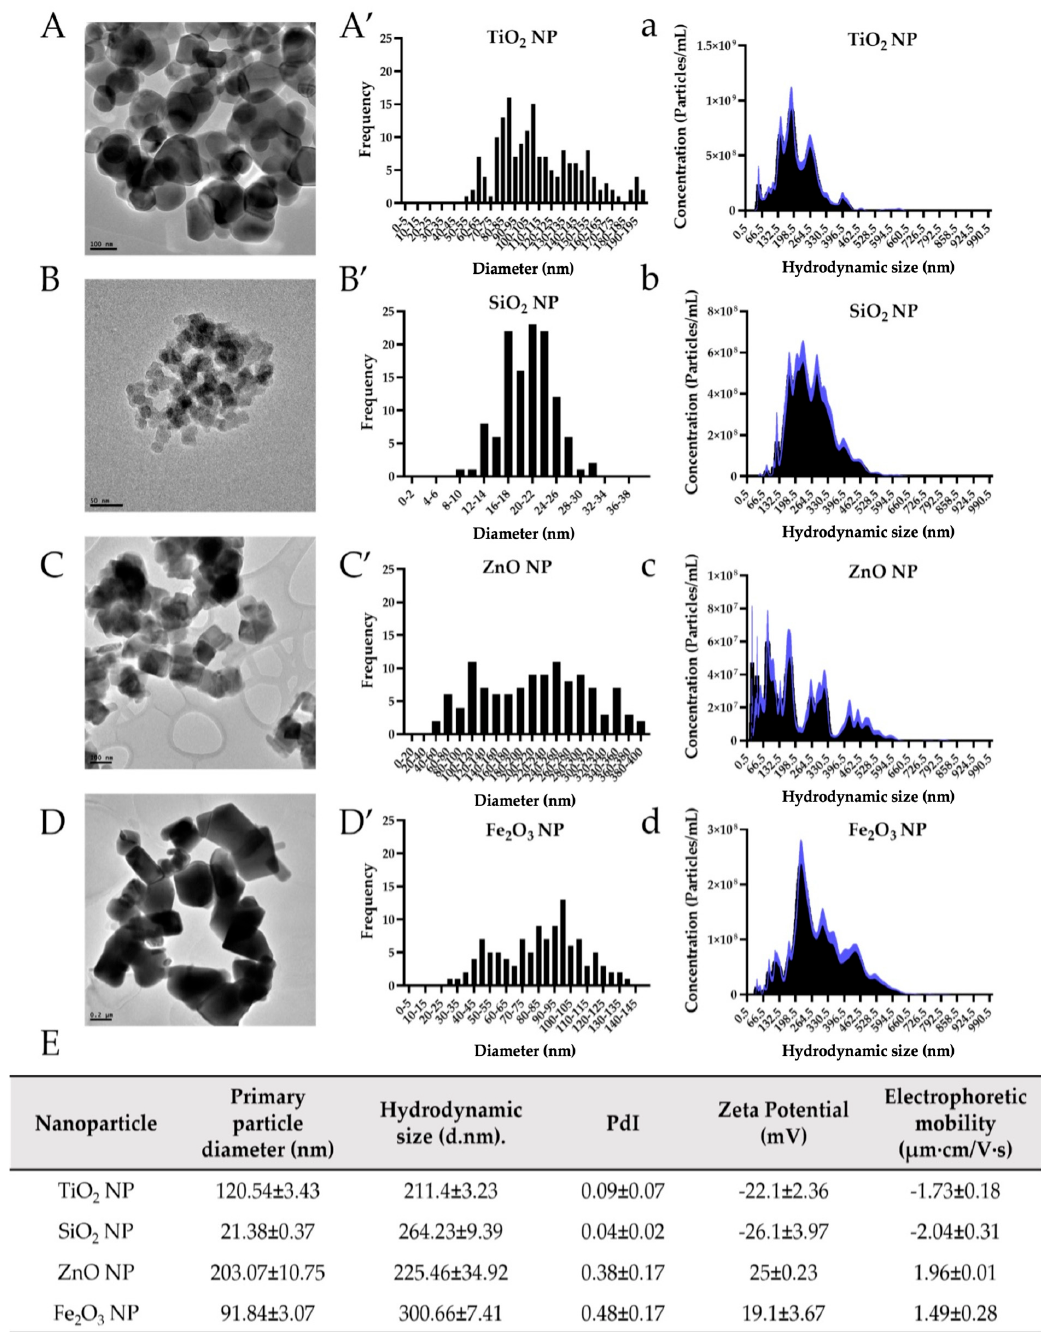
Figure 2. Food-grade nanoparticles (NP) characterization. Transmission electron microscopy (TEM) images of TiO 2 NP ( A ), SiO 2 NP ( B ), ZnO NP ( C ), and Fe 2 O 3 NP ( D ) in dry form. Frequency